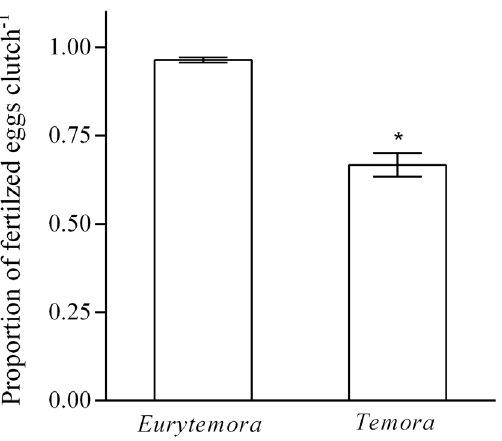
Figure 1. The proportion of fertilized eggs within the clutches of Eurytemoraherdmani and Temoralongicornis females (mean 6 SE). Females were captured from the field and their clutches stained with a nuclei specific probe ( n =68 and n =83 for E. herdmani and T. longicornis, respectively). Proportion of fertilized eggs were compared using a generalized linear model with a quasibinomial distribution and logit-link function ( F 1,150 =109, p , 0.001).